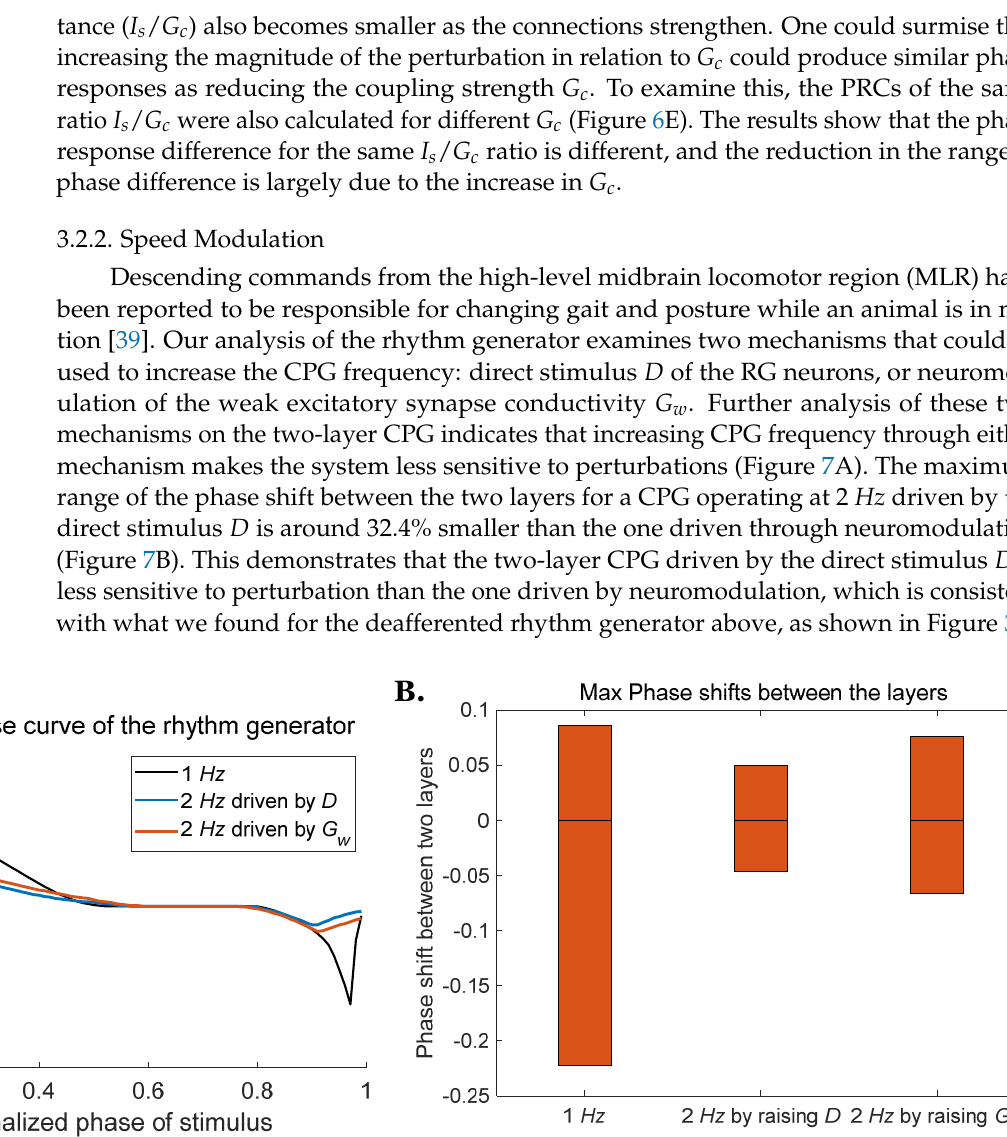
Figure 7. PRCs and maximum phase shift for the rhythm generator as frequency increases. ( A ) PRCs for the rhythm generator at 2 Hz driven by D or neuromodulation of G w . ( B ) Range of phase shift between the two layers when oscillation frequency is increased.